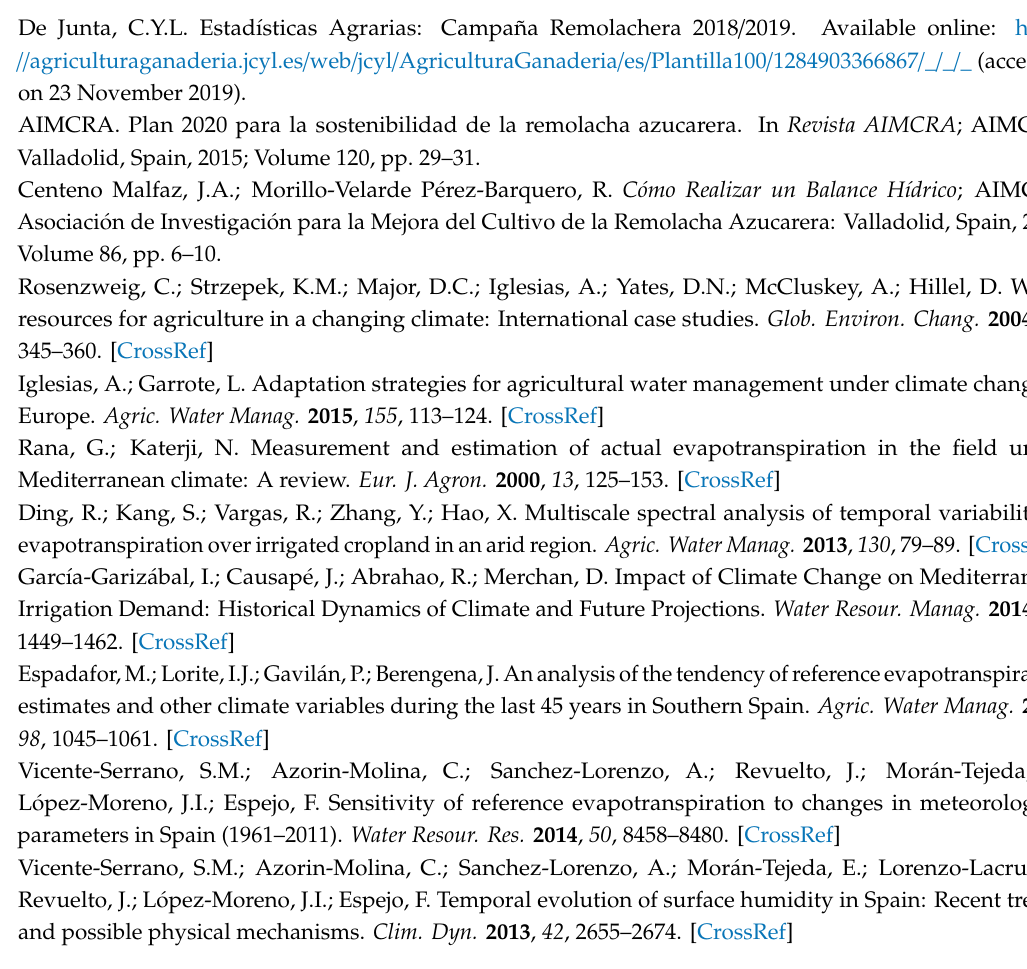
Figure S1: Flowchart summarizing the methodology used in the study; Table S1: Comparison between observed and interpolated annual ET 0 values for the weather stations for “leave one out”